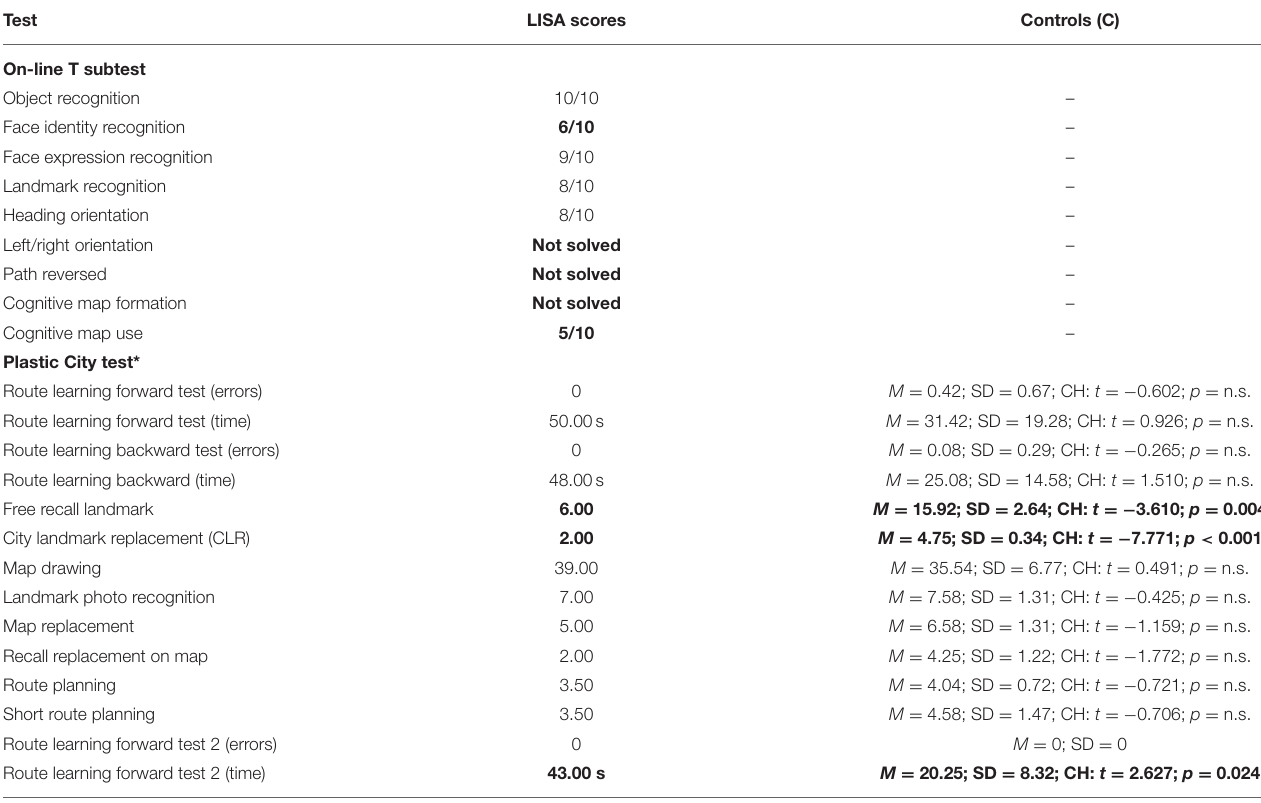
TABLE 3 | LISA’s results in on-line T and Plastic City test